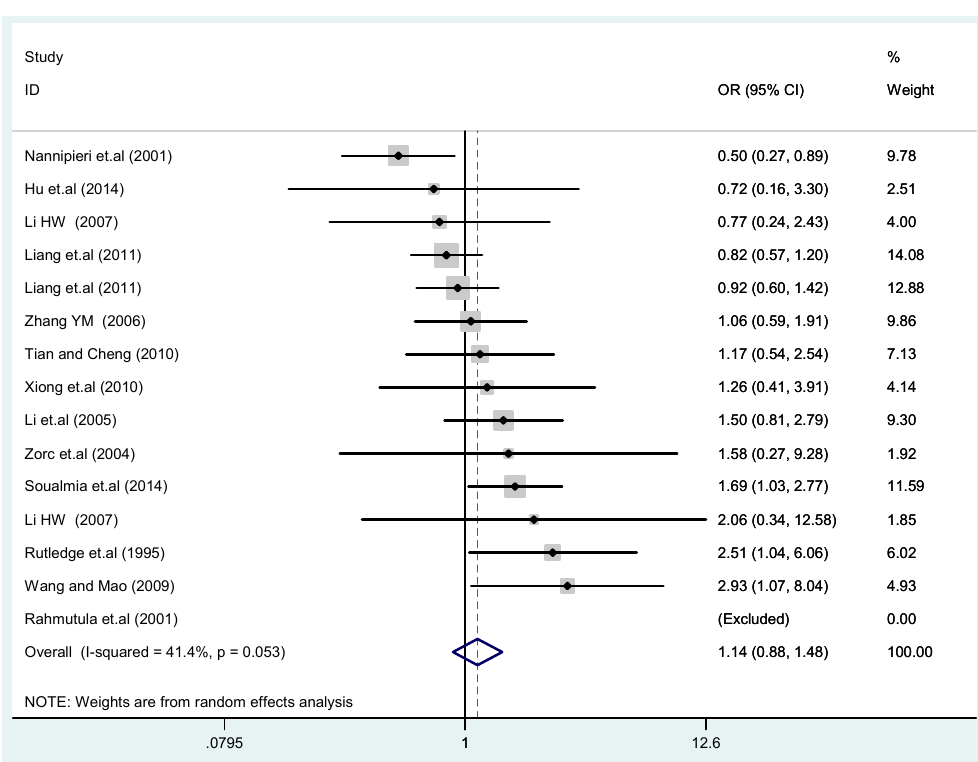
Figure 2. Forest plot of overall population of T2238C additive model (C vs. T).